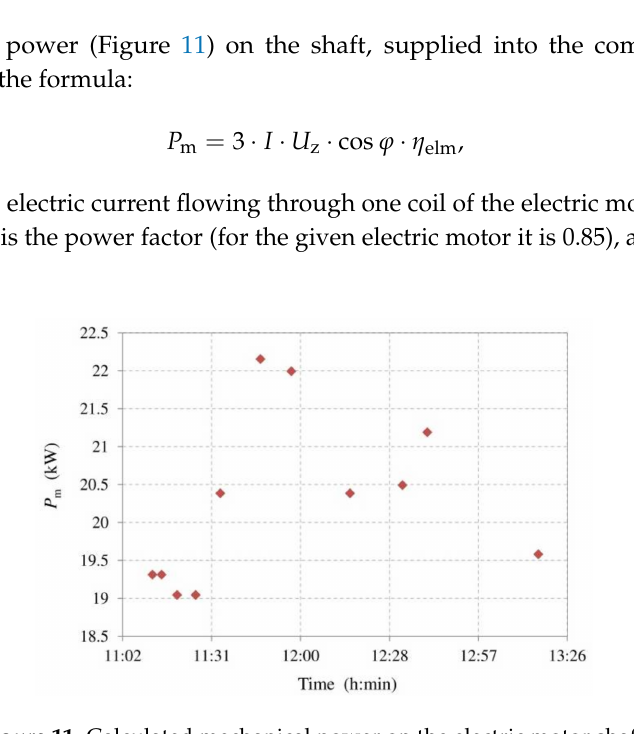
Figure 11. Calculated mechanical power on the electric motor